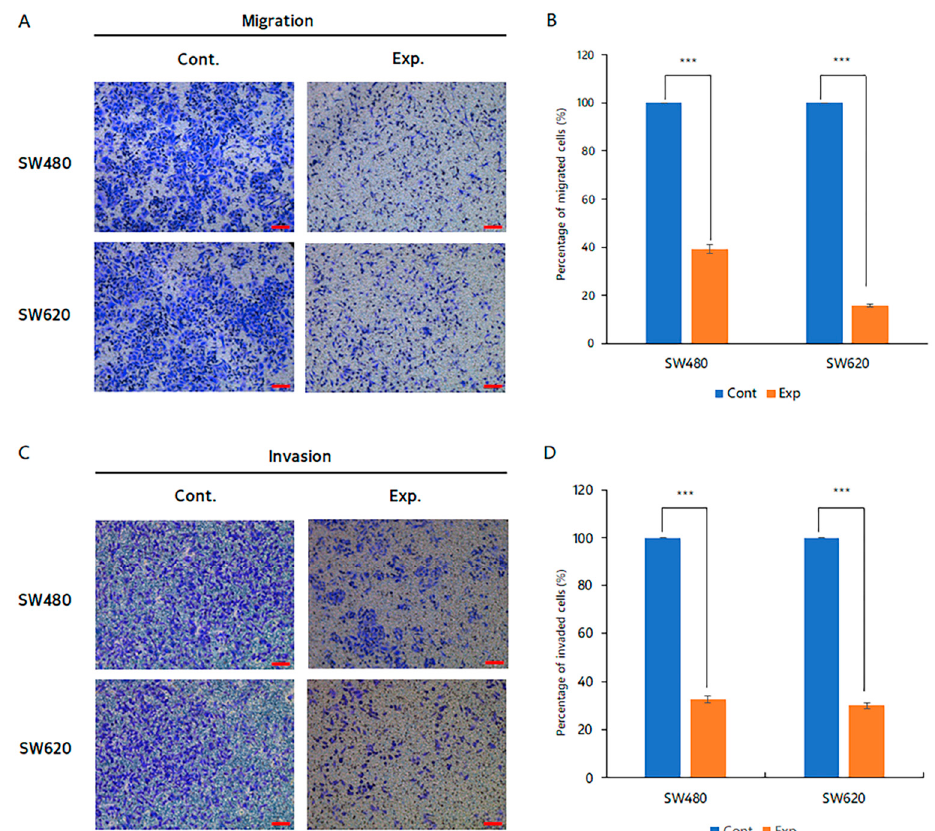
Figure 4. Migration and invasion confirmation test by siTSPAN5. ( A ) Evaluation of SW480 and SW620 cell migration ability. (Scale bar 100 µ m). ( B ) Relative migration rate graph of each cell line (*** p < 0.001). ( C ). Evaluation of SW480 and SW620 cell invasion ability. (Scale bar 100 µ m). ( D ) Relative invasion rate graph of each cell line rate (*** p < 0.001).